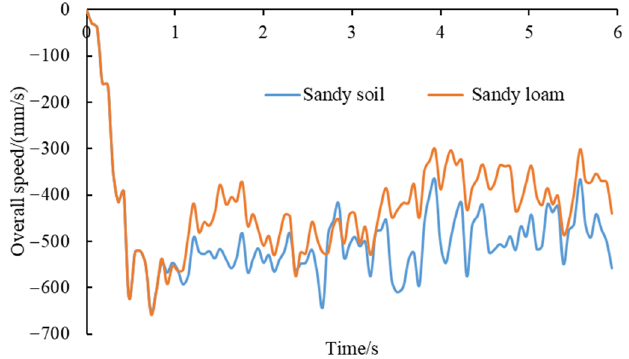
Figure 7. Overall speed of the cavity planter travelling on two different soils.